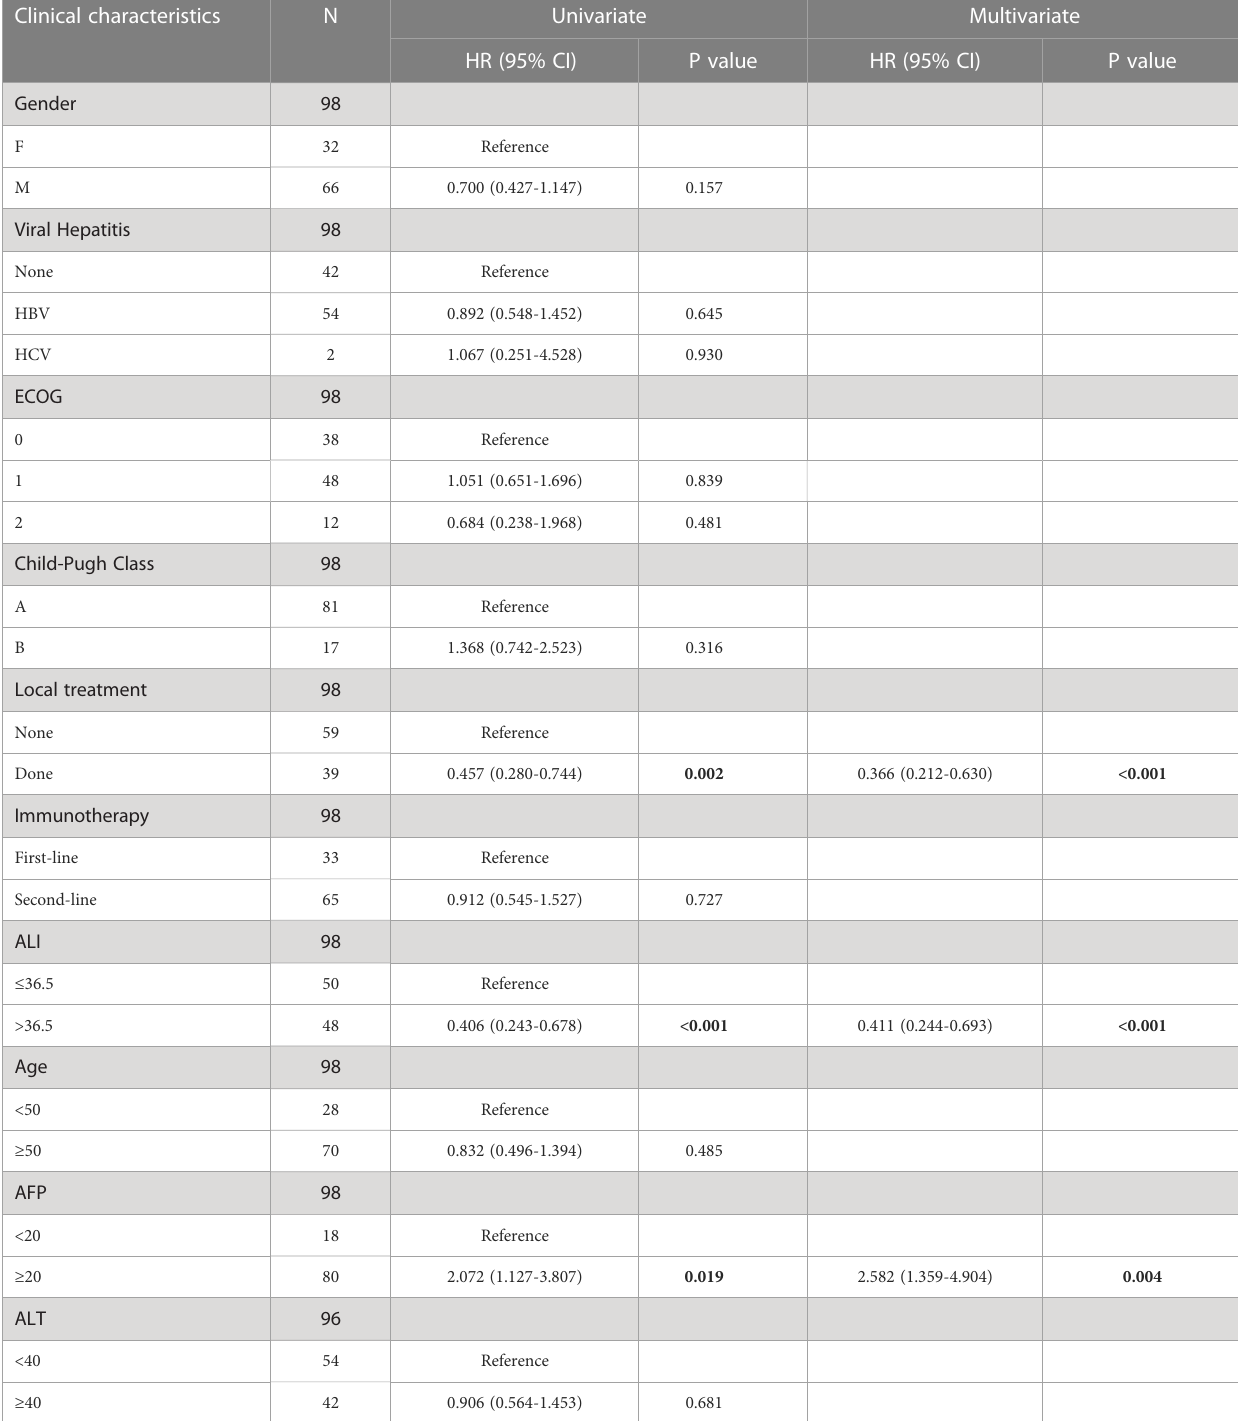
TABLE 3 Univariate and Multivariate analysis of poor prognostic factors for OS in HCC patients. Clinical